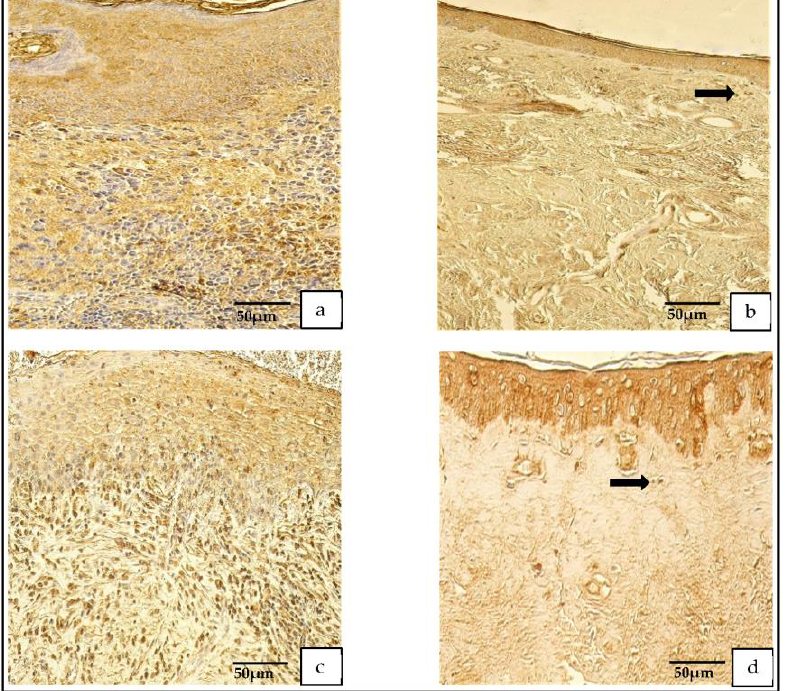
Figure 5. ( a – d ) Immunohistochemical micrographs. ( a ) Cholesteatoma . Numerous TIMP–2-positive cells in the matrix and moderate in the perimatrix, TIMP–2 IHC. ( b ) Skin . Moderate-to-numerous TIMP–2-positive cells in the epithelium and a few in the connective tissue (arrow), TIMP–2 IHC. ( c ) Cholesteatoma. Moderate-to-numerous TIMP-4-positive cells in matrix and numerous in the perimatrix, TIMP-4 IHC. ( d ) Skin. Moderate-to-numerous TIMP-4-positive cells in the epithelium and a few in the connective tissue (arrow), TIMP-4